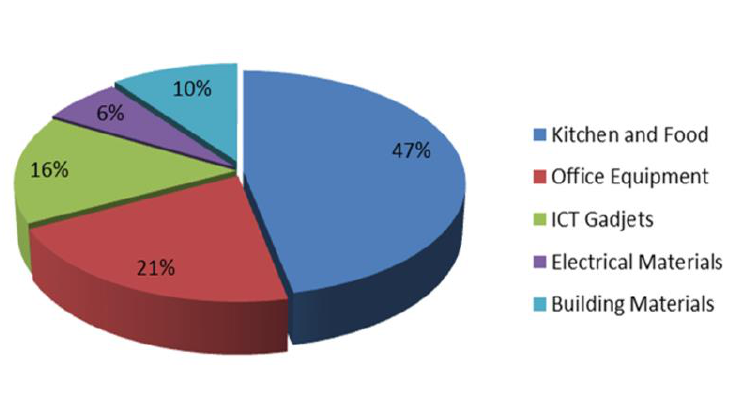
Figure 6: Percentage distribution of looted